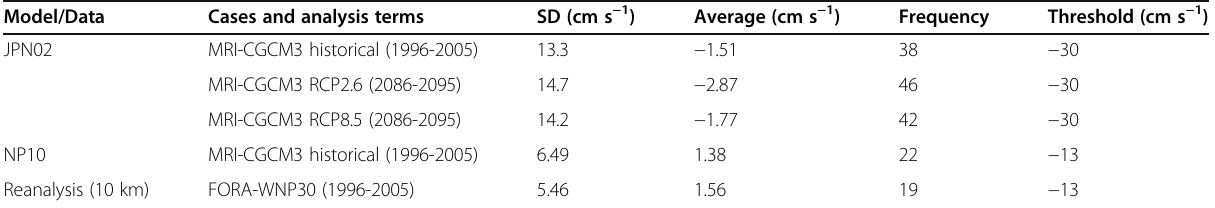
Table 6 Statistics of the meridional velocity (cm s − 1 ) and the sudden increase events ( “ Kyucho ” events) at P in Sagami Bay. “ Average ” and “ SD ” denote the 10-year average and standard deviation of the meridional velocity at P, respectively. The 10-year “ Frequency ” of the “ Kyucho ” events at P in each case was evaluated based on the “ Threshold ” velocity value ( − 30 cm s − 1 or − 13 cm s − 1 )